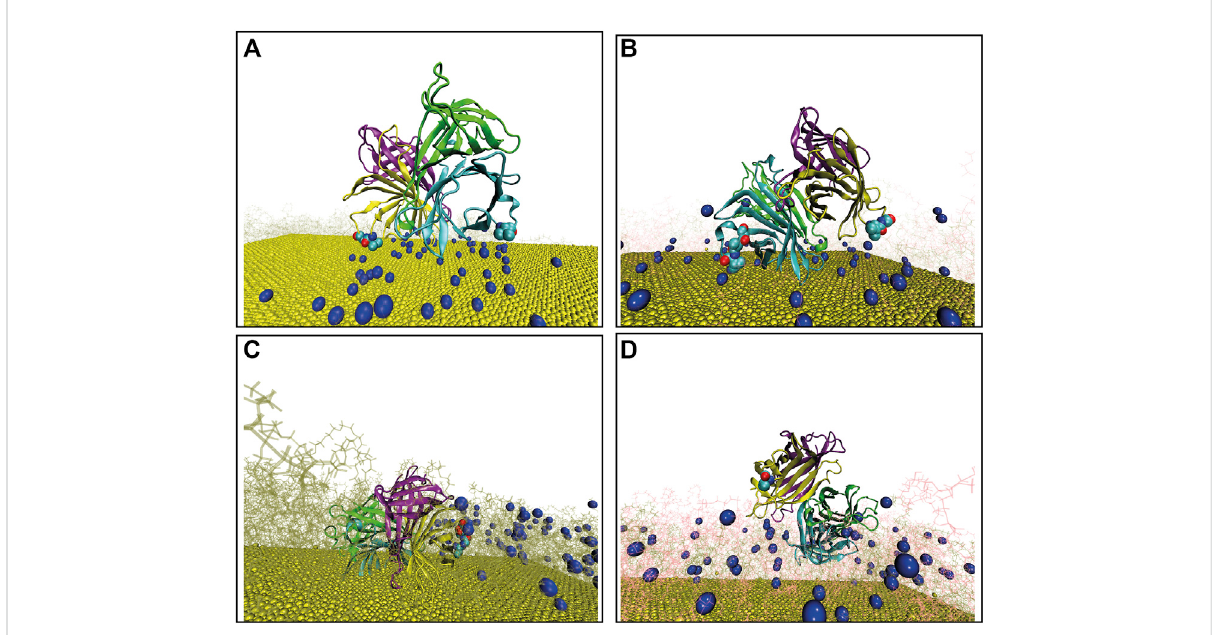
FIGURE 1 Finalcon fi gurationofStreptavidinasdockedoverfourdifferentsurfaces,terminalbiotinatomsareshownbysphericalrepresentation(blue),Au (111) in yellow, PEGs are in pink, bPEGs in green, and the protein is shown in a cartoon representation with four different colors for tetramers, vdW representationofproteinsaretheresiduesinproximitywithbPEG/PEGinthedockedcomplex; (A) 49bPEG; (B) 25bPEG-24PEG; (C) 98bPEG;and (D)